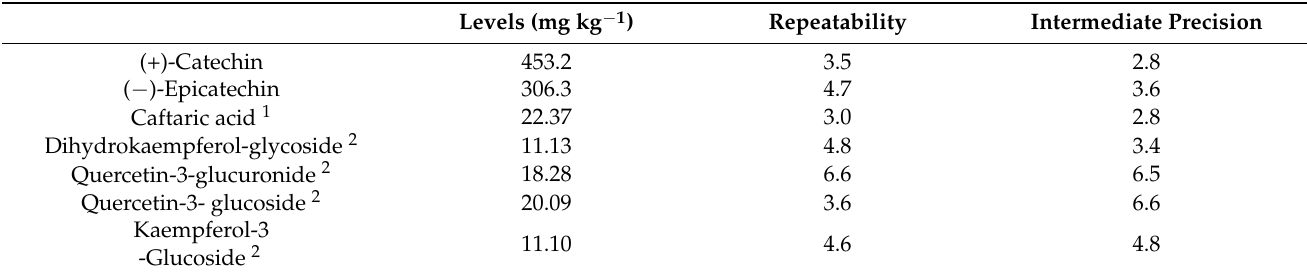
Table 3. Levels (mg Kg − 1 dw), intra-day ( n = 9) standard deviations, and inter-day ( n = 9) standard deviations for the method carried out for the phenolic compounds analyzed.